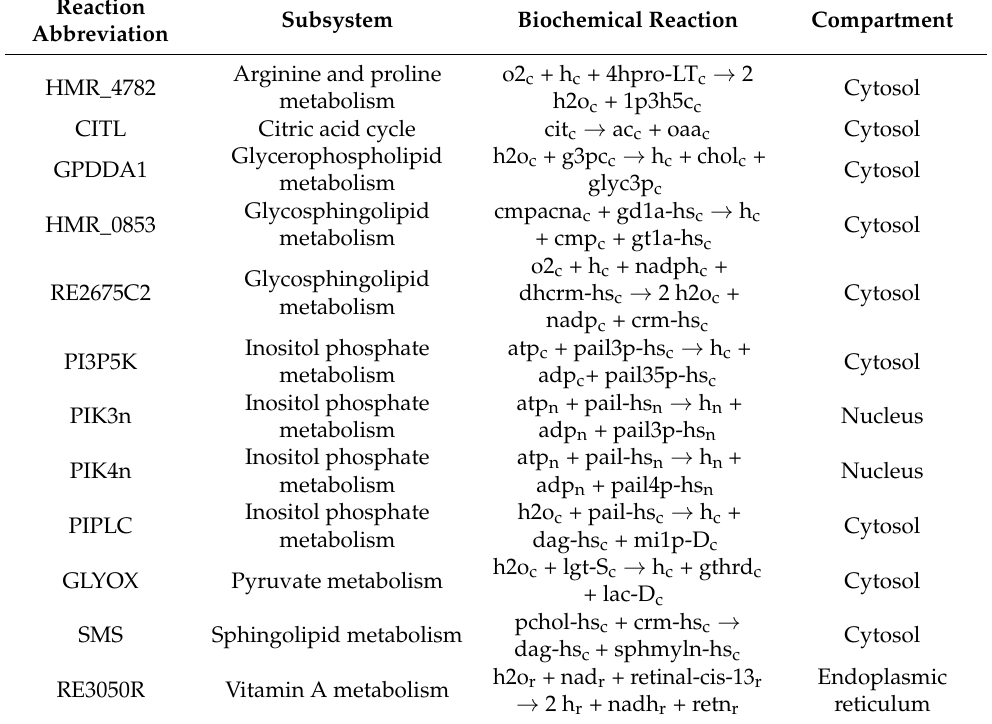
Table 2. Selected reactions and corresponding subsystems with increased flux in Urat1/Rst KO rela- tive to the WT model. Reactions that were at least 1.5 times the mean flux in KO compared to WT were selected and further filtered by removing exchange/transport reactions, exogenous metabolism, and fatty acid oxidation/synthesis. Redox cofactor balances and charges are noted in multiple reactions. Interestingly, generation of lactate as a by-product in order to produce (reduced) glutathione (GLYOX) provides a link to how the increased fluxes related to the unique Urat1KO reactions (Table 1).